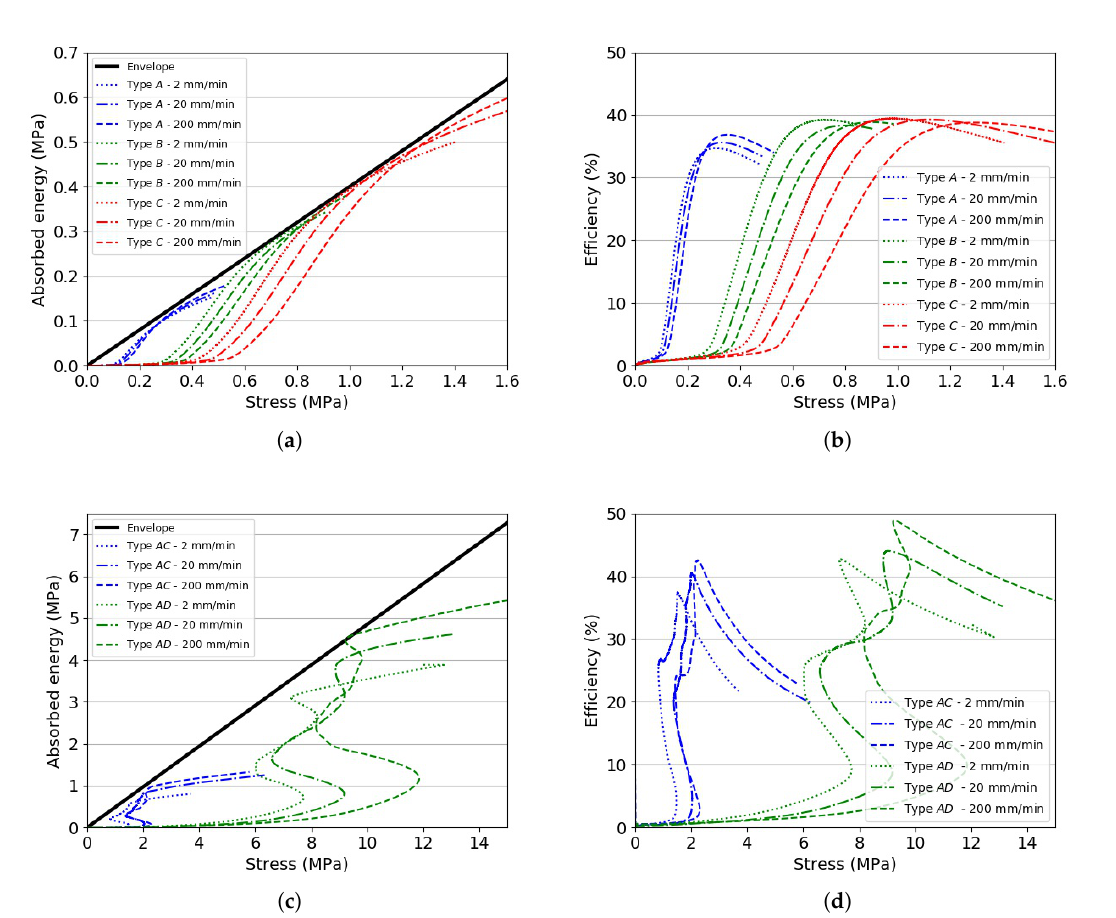
Figure 7. ( a ) Absorbed energy vs. stress for Specimens A , B and C (EPP); ( b ) efficiency diagram for Specimens A , B and C (EPP); ( c ) absorbed energy vs. stress for Specimens AC and AD (3D printed PA); ( d ) efficiency diagram for Specimens AC and AD (3D printed